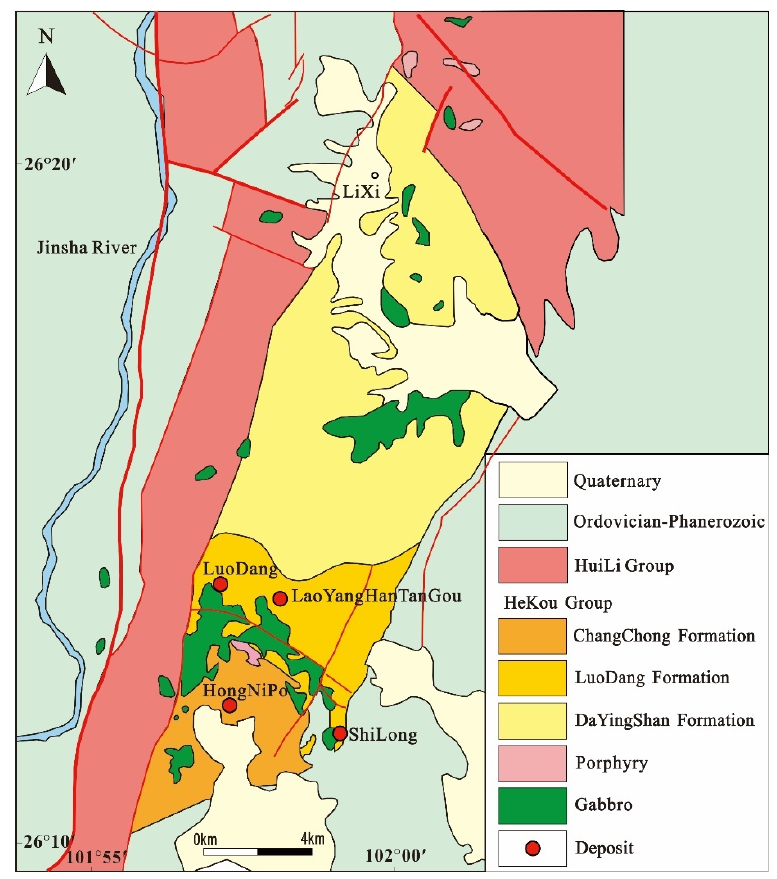
Figure 3. Distribution map of copper deposits in the Lala area (modified from [24,27]).